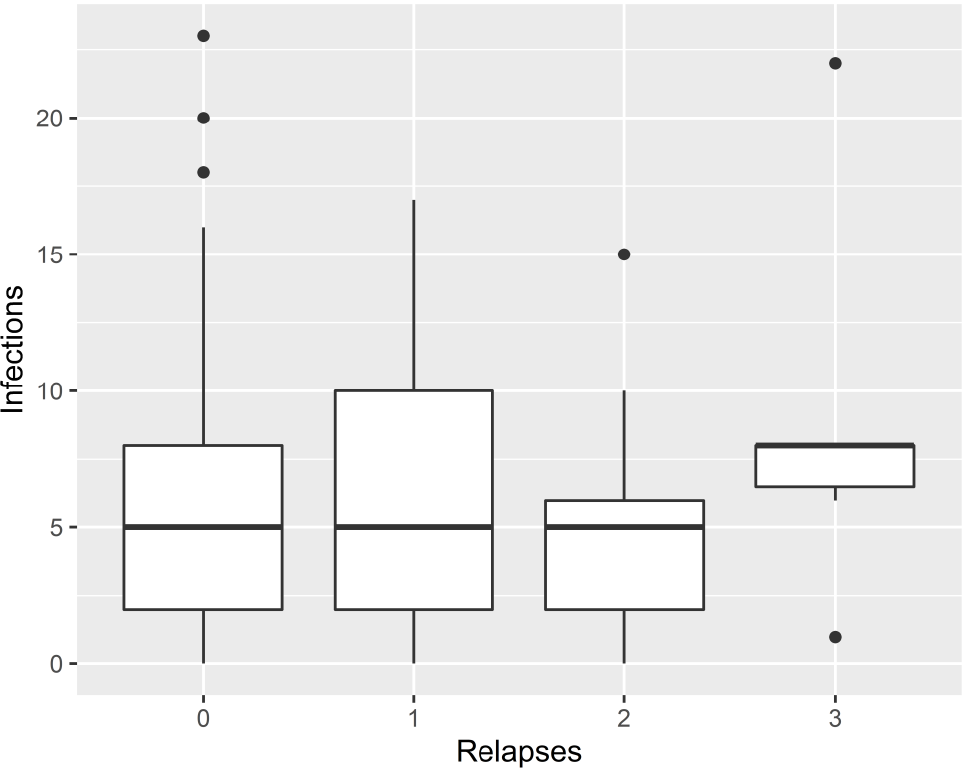
Figure 2. Correlation between the total number of infections and total number of relapses by patients.